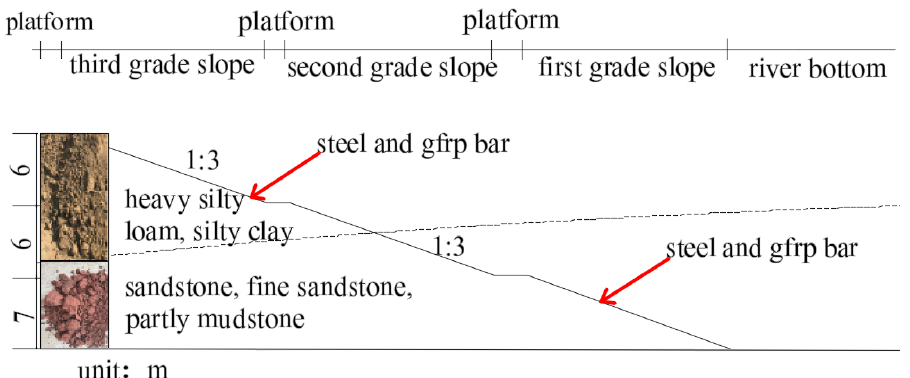
Figure 1. Location of the test site.